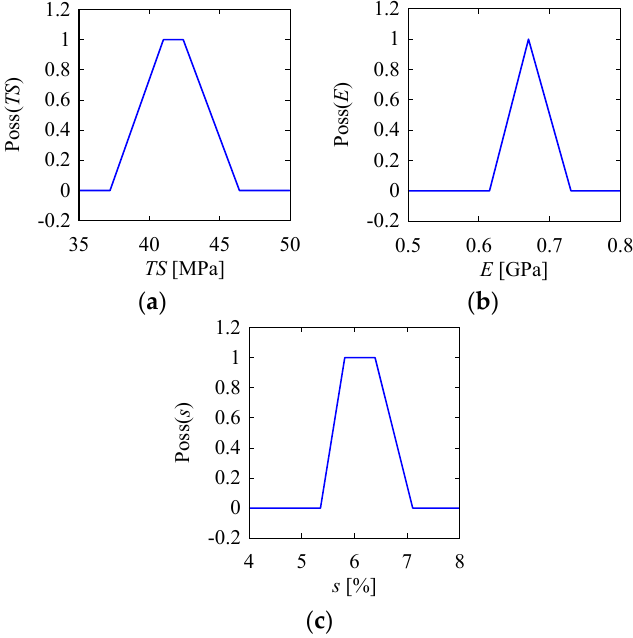
Figure 9. Possibility distributes of ( a ) tensile strength; ( b ) modulus of elasticity; and ( c ) strain to failure of jute yarns.